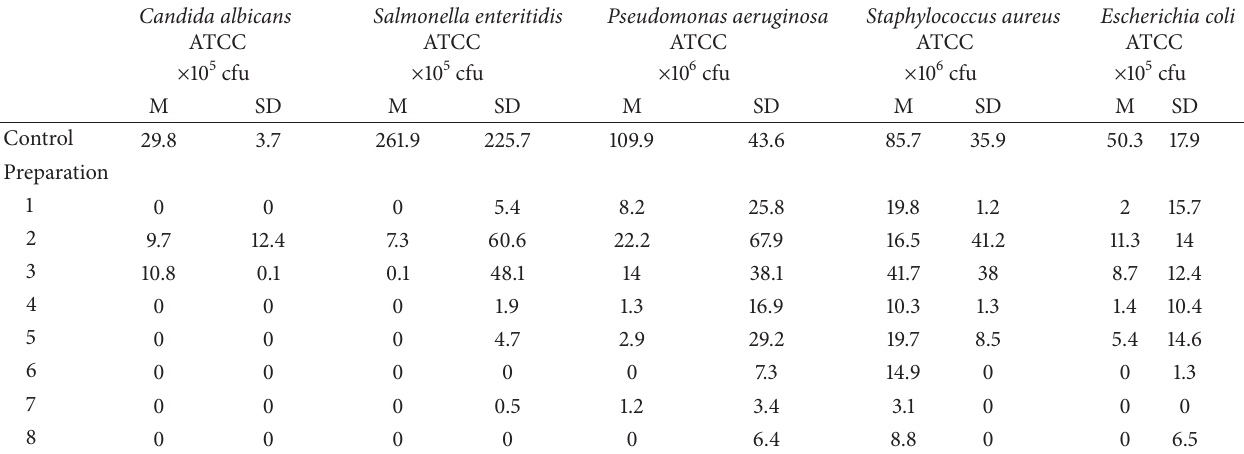
Table 5: The number of bacterial and fungal cells grown after 30 minutes of contact with nanosilver compared to control group.